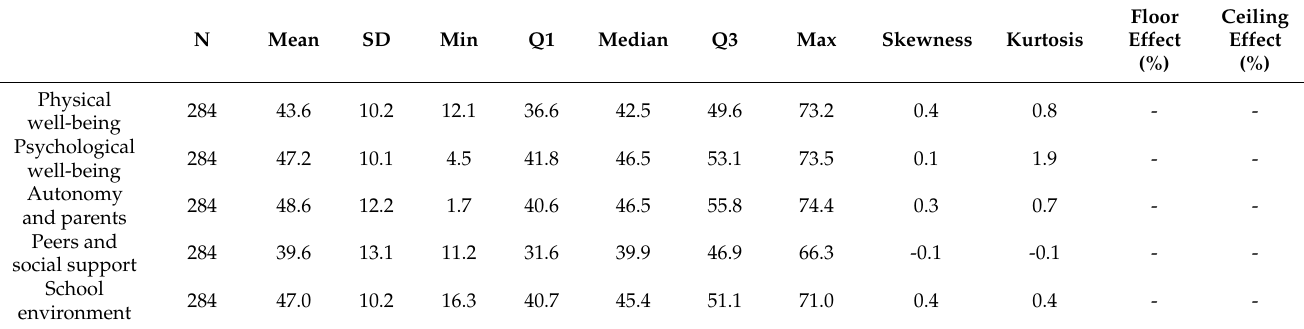
Table 6. Overall KIDSCREEN27 scores per dimension (N =